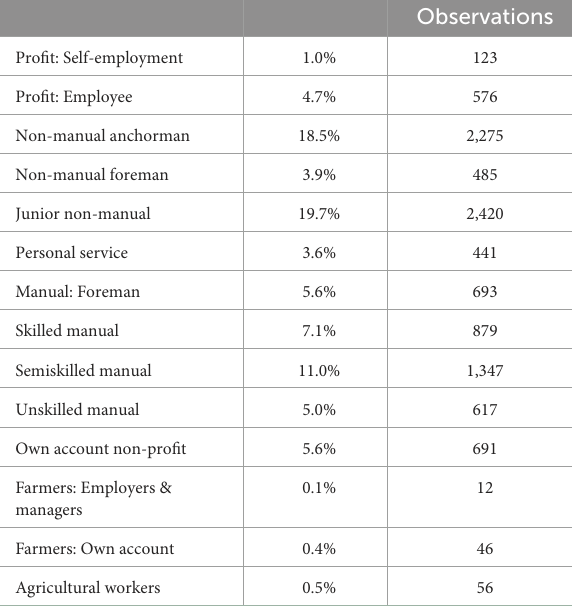
TABLE 1 Summary of descriptive statistics.